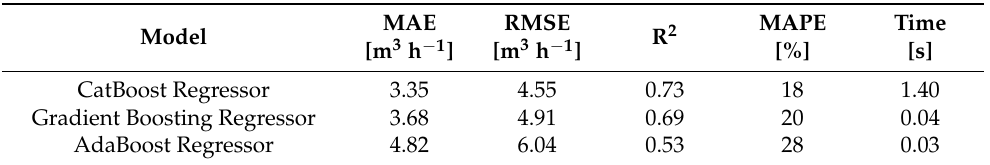
Table 5. Evaluation metric of models based on gradient-boosted machine applied to the training set from mechanized timber harvesting